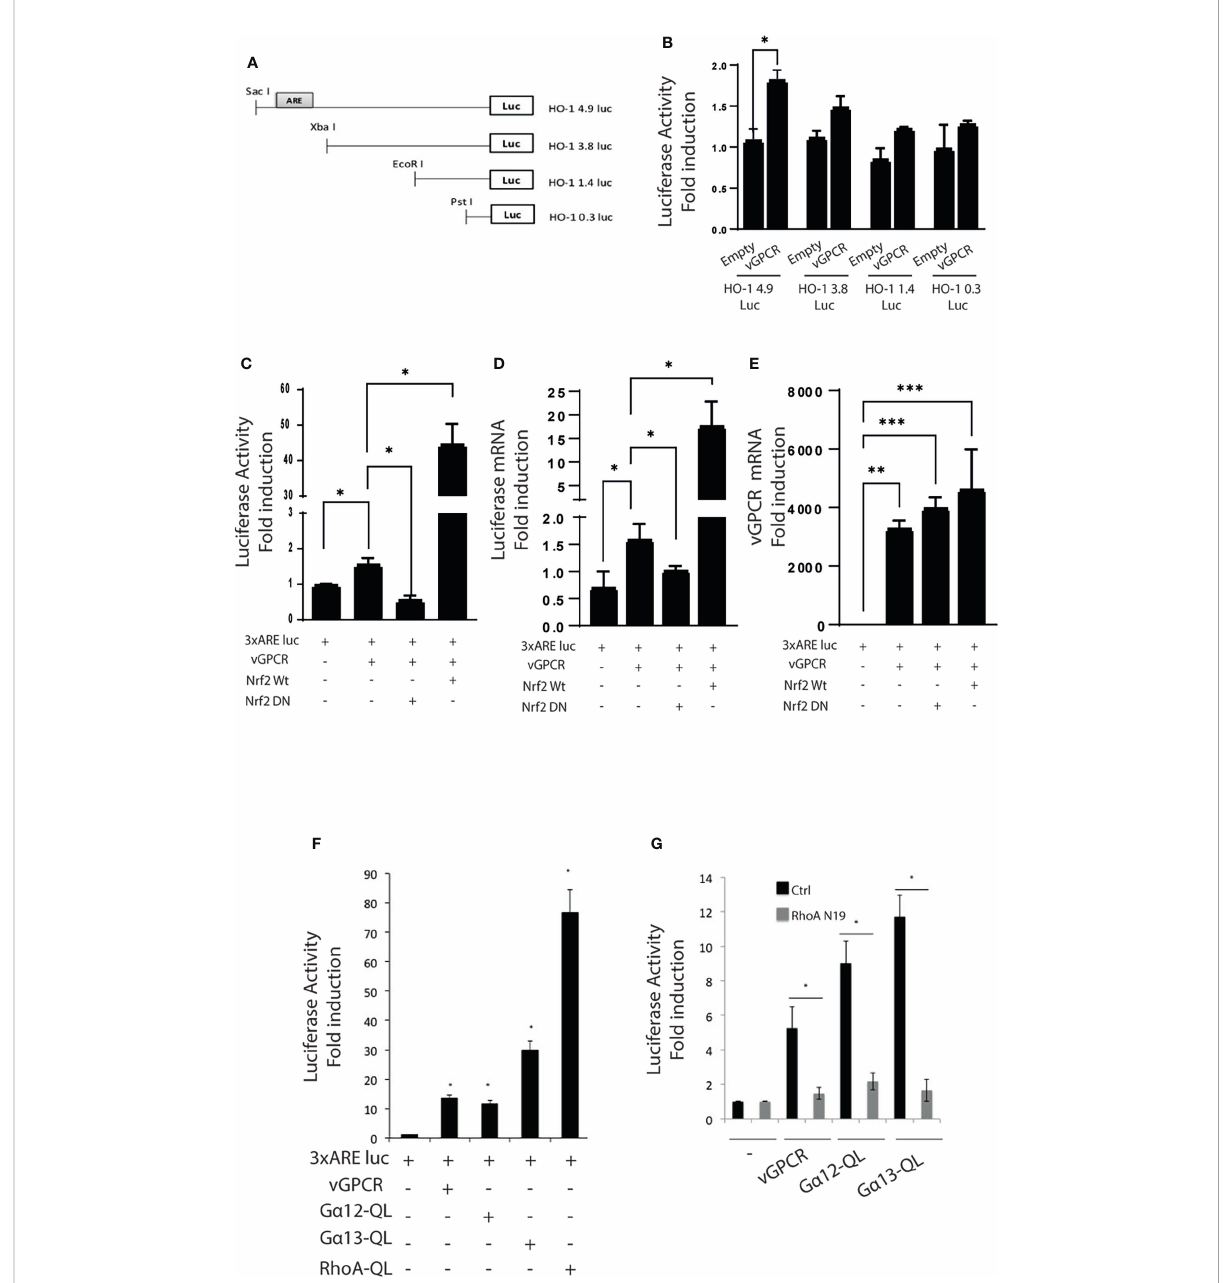
FIGURE 1 (A) Serial deletions of the 4.9Kb region of the HO-1 promoter. (B) Luciferase activity of serial deletions of the HO-1 promoter after co-transfection of the reporter construct with a plasmid that expresses vGPCR. The results are expressed as fold induction relative to cells transfected with the 4.9Kb promoter construct. (C) Luciferase activity of a minimum promoter with three ARE sites in tandem (3xARE Luc) after transfection of vGPCR; effect of co-transfection with vGPCR and Nrf2 WT, and effect of co-transfection with vGCPR and Nrf2 DN. The results are expressed as fold induction relative to control cells (transfected with the reporter and an empty vector). (D) Fold-changes of Luciferase mRNA expression were assessed by RT-qPCR in triplicate and are presented as means ± SD. (E) Fold-changes of vGPCR mRNA expression were assessed by RT-qPCR in triplicate and are presented as means ± SD. (F) Luciferase activity of the 3xARE Luc reporter constructs after transfection with plasmids expressing vGPCR, G a 12-QL, G a 13-QL, and RhoA-QL (constitutively active forms of G a 12, G a 13, and RhoA, respectively). The results are expressed as fold induction relative to control cells (transfected with the reporter and an empty vector). (G) Luciferase activity of the 3xARE Luc after co-transfection with vGPCR, G a 12-QL, and G a 13-QL with or without RhoA-N19 (a dominant negative form of RhoA). The results are expressed as fold induction relative to control cells (transfected with the reporter and an empty vector). P-value < 0.05 (*). P-value <0.002 (**). P-value <0.0002